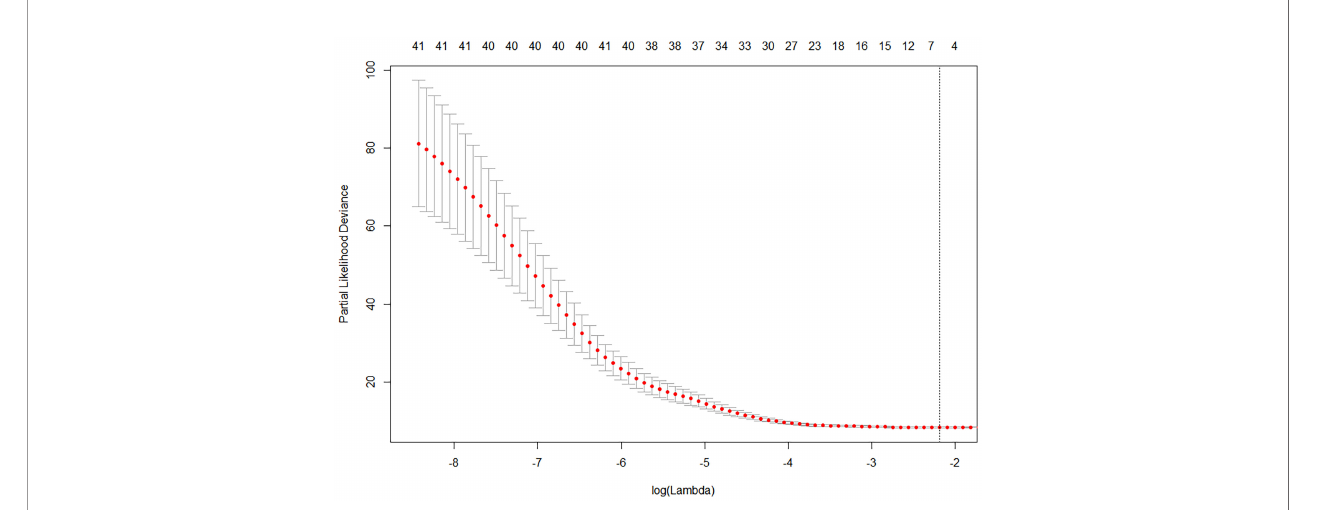
FIGURE 2 | Selecting prognostic variables by using LASSO analysis.